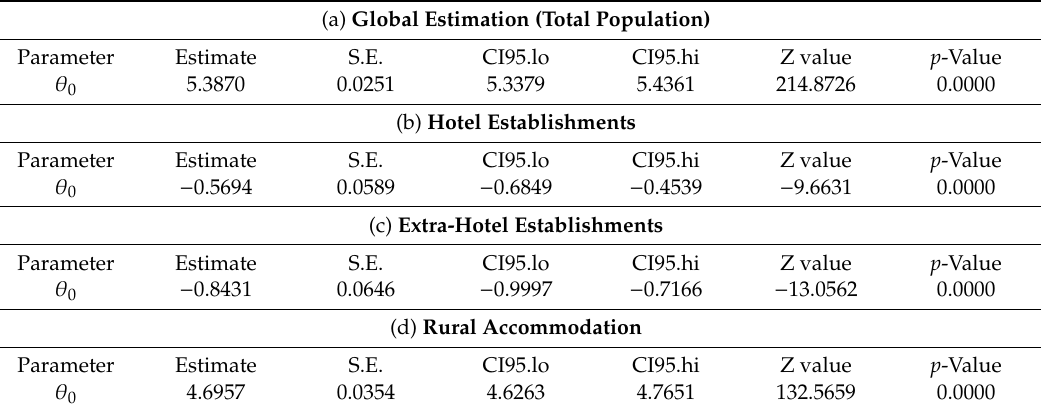
Table 2. Estimation of model (1) λ ( u ,x ) = exp ( θ 0 )